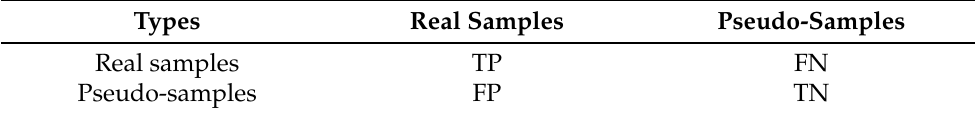
Table 5. The confusion matrix.